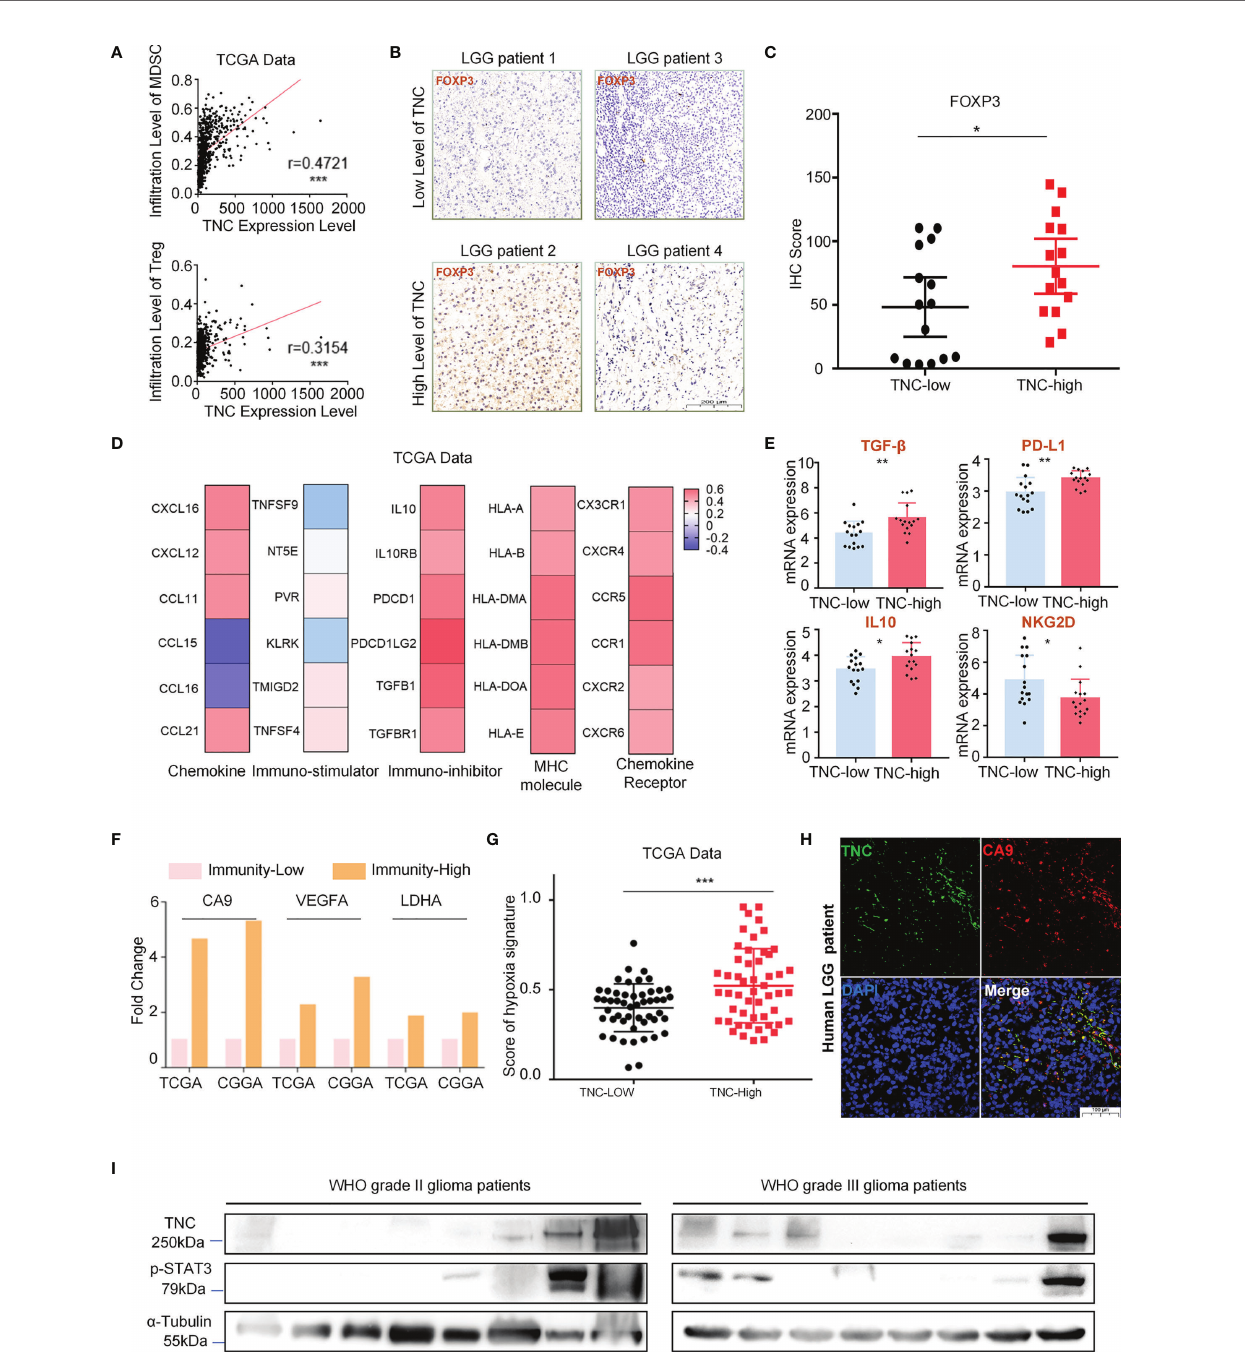
FIGURE 4 | TNC was mainly related to the immunosuppressive microenvironment of LGGs. (A) Scatter plot displaying the correlation between TNC mRNA level and MDSC/Treg cell level. (*** p < 0.001) (B) IHC staining of FOXP3 protein in LGG specimens in terms of TNC IHC scores level. (Scale bars = 200 um . The sample is consistent with Fig. 2d, 2e) (C) Scatter plot showing the distribution of FOXP3 IHC scores in the two subgroups grouped by the median of the TNC IHC score. (* p <0.05) (D) Heatmap re fl ecting the correlation between TNC and chemokine, immuno-stimulator, immune-inhibitor, MHC molecule, and chemokine receptor. (E) qRT-PCR analysis of mRNA expression of IL10, TGF- b , PD-L1 and NKG2D in 32 LGG patients grouped by TNC mRNA level. (* p < 0.05; ** p < 0.01). (F) The histogram showing the mRNA expression difference of hypoxia markers (CA9, VEGFA, and LDHA) in high-immunity subgroup and low-immunity subgroup. (G) Scatter plot exhibiting the distribution of hypoxia signature scores in the two subgroups based on the median of TNC mRNA level in TCGA data. (*** p < 0.001). (H) IF staining of TNC (green) and hypoxia marker (CA9; red) in human LGGs. (Scale bars=100 um , representative images are shown) (I) Immunoblotting of TNC and p-STAT3 in grade II and III glioma patients. ( n